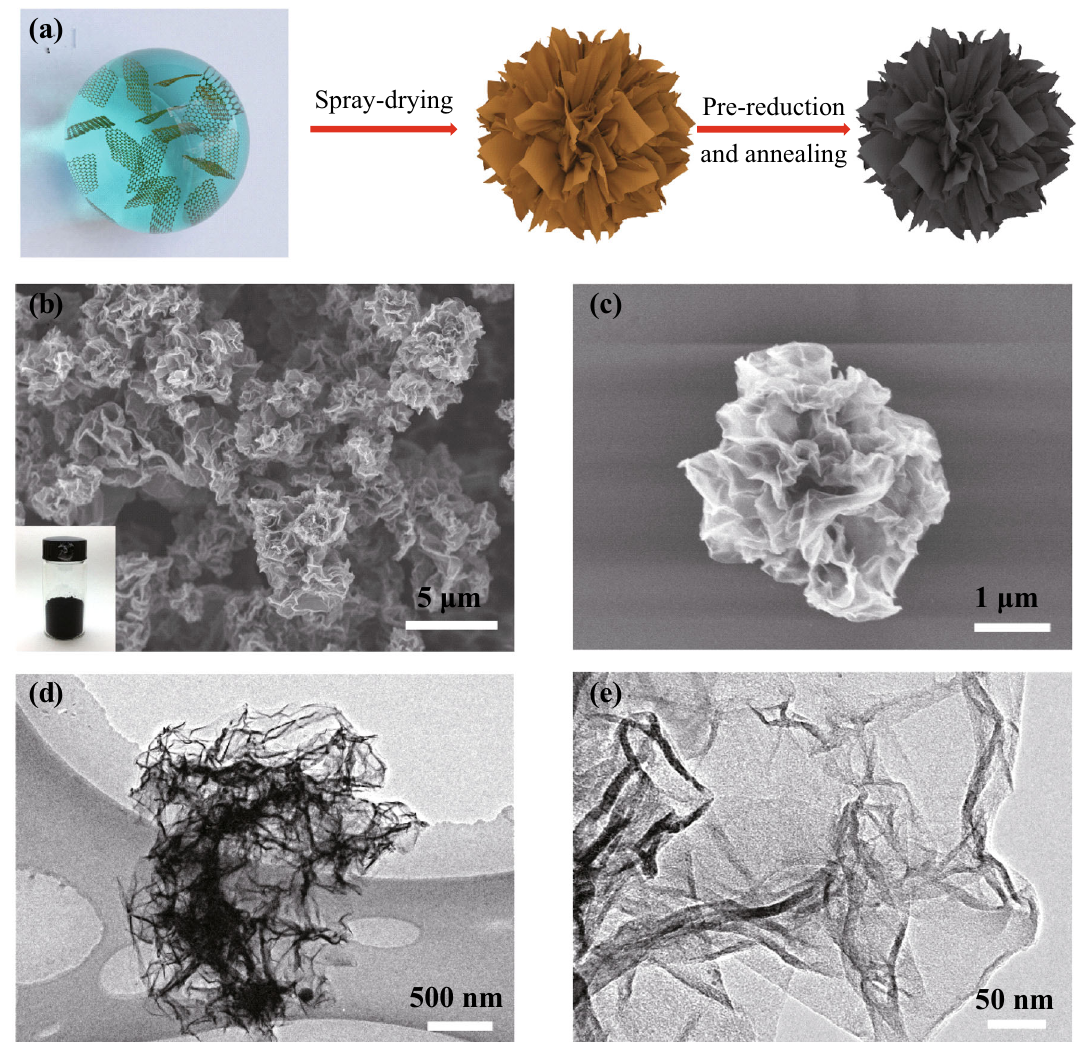
Fig. 1 a Schematic illustration of the formation of Gmfs. b , c SEM images of Gmfs. The insert is the digital picture of the 0.4 g Gmfs powder in a 20-mL bottle. d , e TEM images of an individual